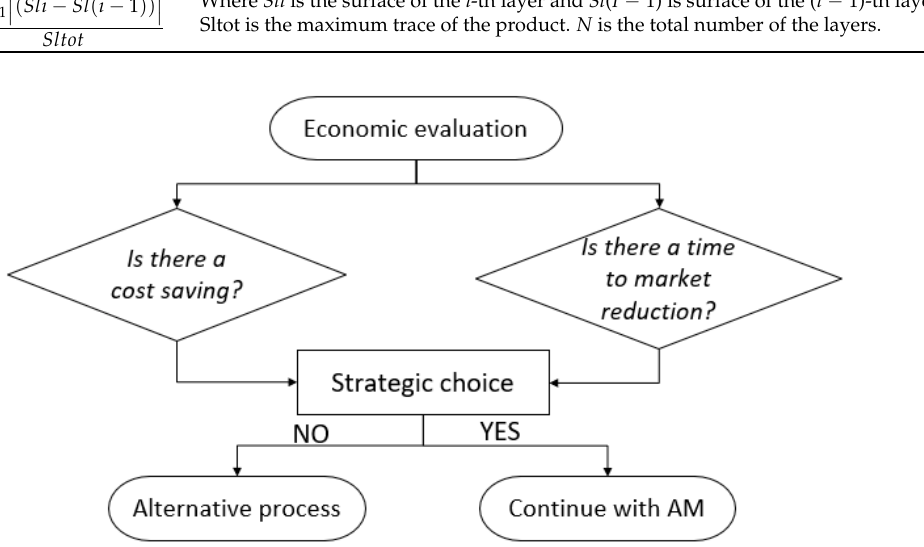
Figure 6. Final assessment of cost and time-to-market.